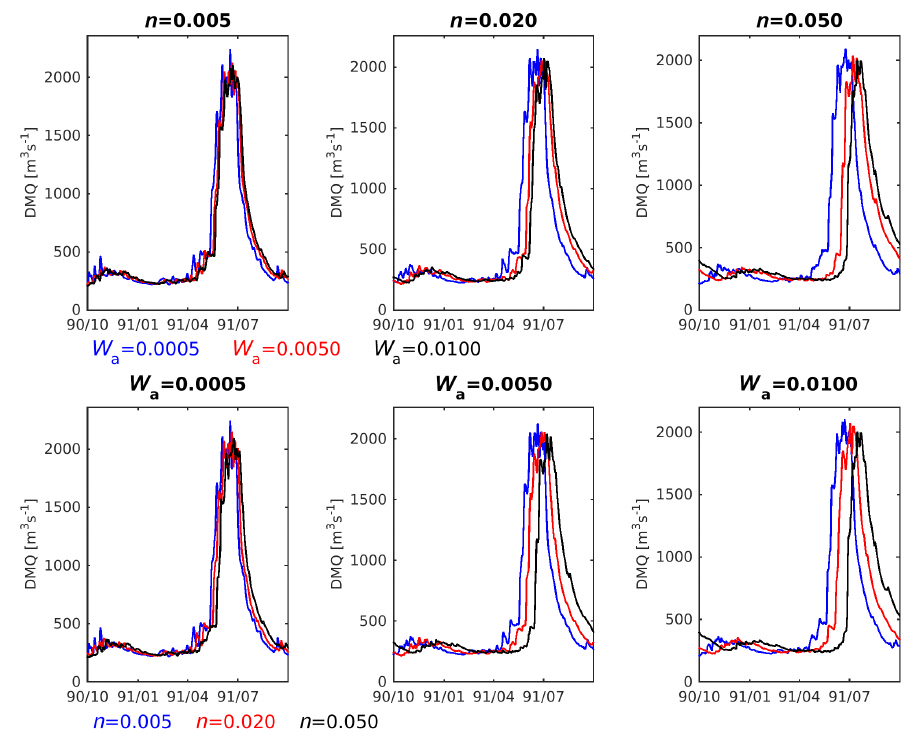
Figure 8. Sensitivity of simulated runoff at Colorado River at Lees Ferry (Location B in Fig. 5) to the two KWT parameters. The top panel shows sensitivity to width factor W a with three fixed Manning coefficients n (from left to right: n = 0.005, 0.02, and 0.05). The bottom panel shows sensitivity to Manning coefficient n with three fixed width factor w (from left to right: W a = 0.0005, 0.0050, and